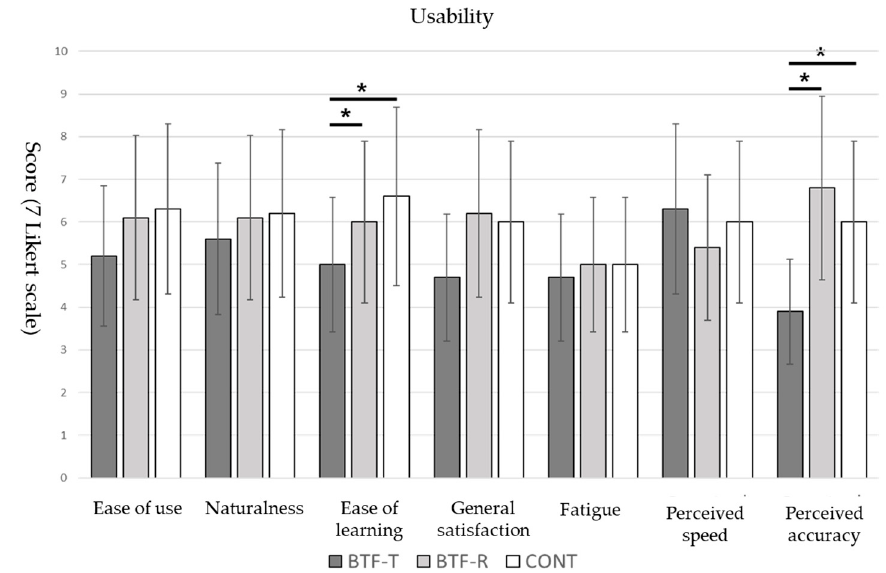
Figure 11. Responses to the survey which generally showed a similar level of usability among the three interface types. BTF-T was the least easy to learn, and perceived to be fast but less accurate. The asterisk mark (*) indicates statistically significant difference.